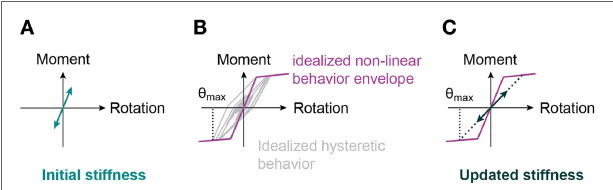
FIGURE 1 | Updated stiffness for a moment-resisting spring undergoing hysteretic non-linear moment-rotation cycles. (A) Initial state, (B) earthquake, and (C) damaged